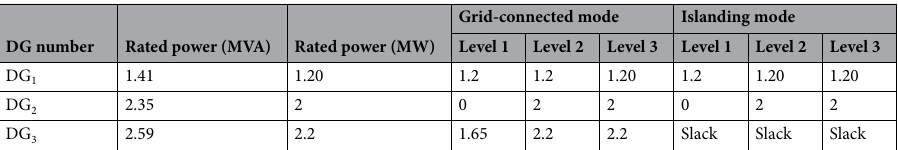
Table 2. Information of DG resources, amount of production of distributed generation resources at different load levels 20 .